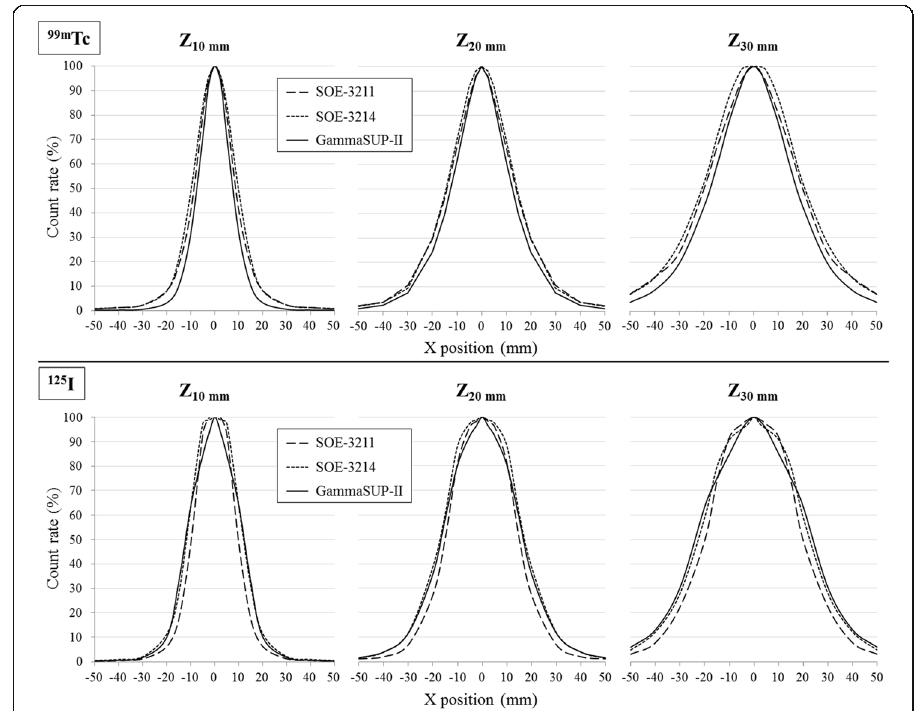
Fig. 5 Spatial resolution profiles of the three probes for 99m Tc and 125 I sources at 10, 20 and 30 mm